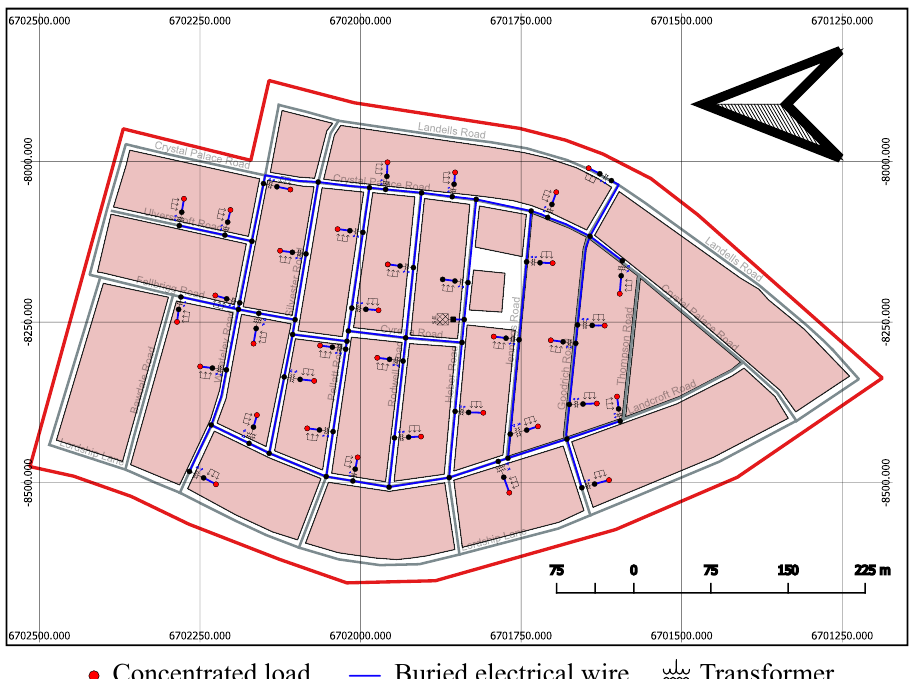
Figure 6. Medium- voltage network of scenario